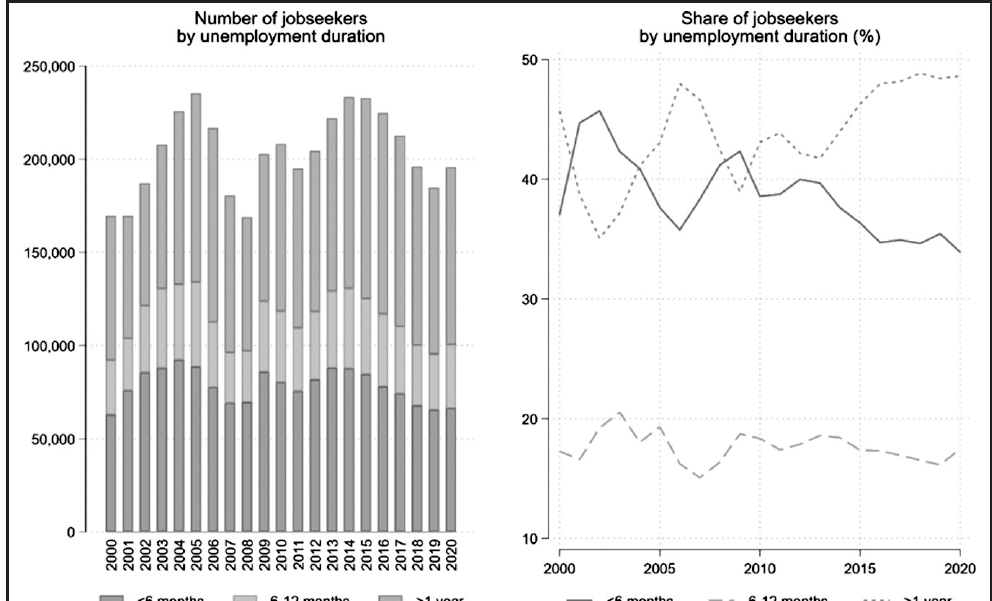
Figure 1 The evolution of long-term unemployment in